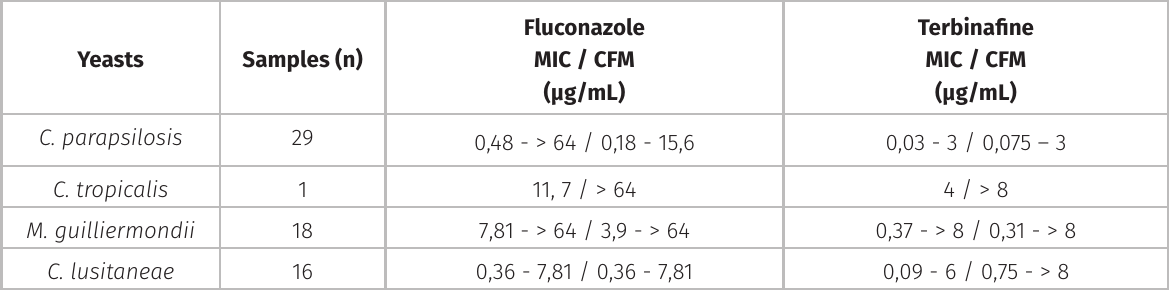
Table I. Variation range of Minimum Inhibitory Concentration (MIC) and Minimum Fungicidal Concentration (CFM) of fluconazole and terbinafine against yeasts isolated in a hospital environment in the city of Pelotas